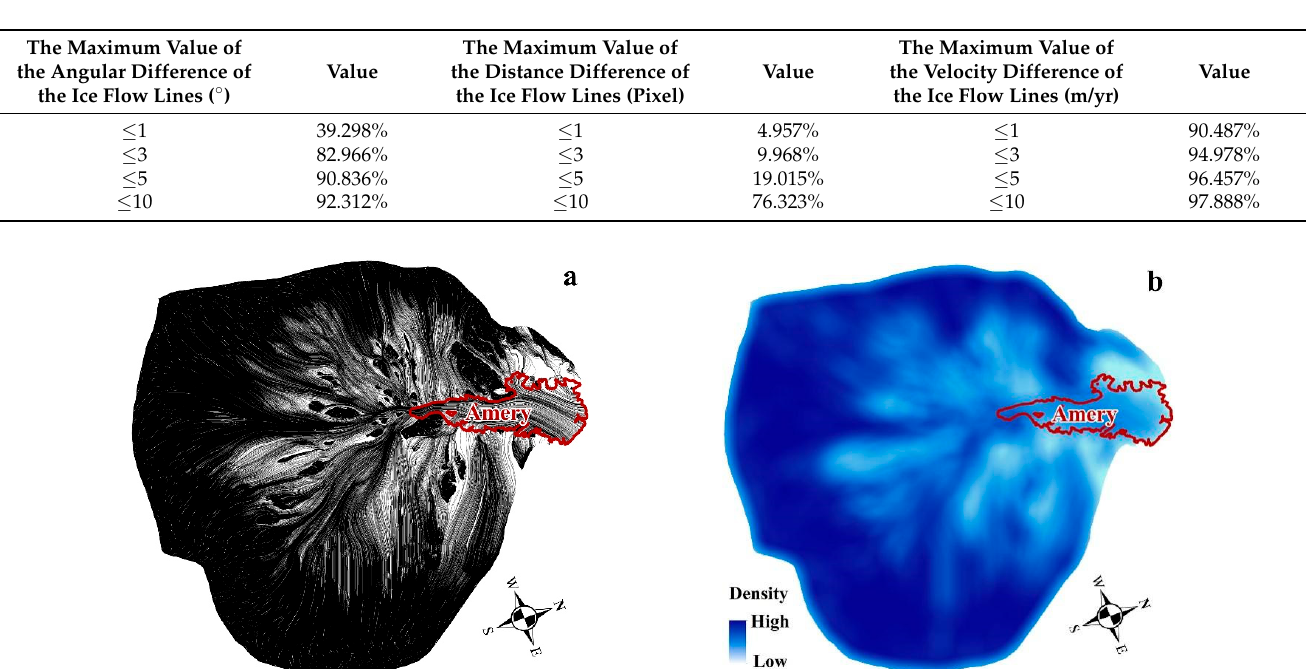
Table 1. The maximum value of the angular difference, distance difference and velocity difference of the ice flow lines.